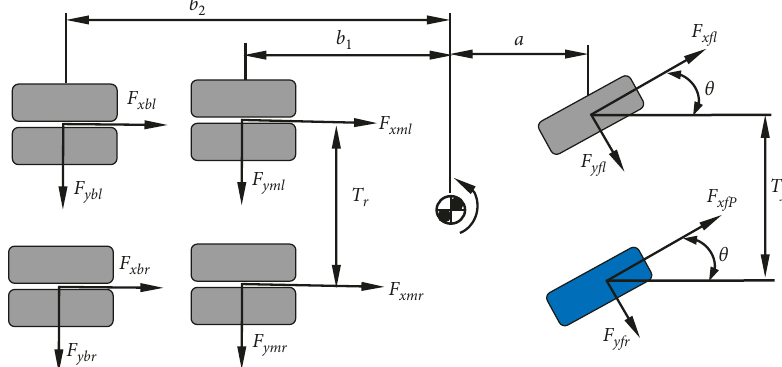
Figure 3: Dynamic model of uncertain braking failure of right front